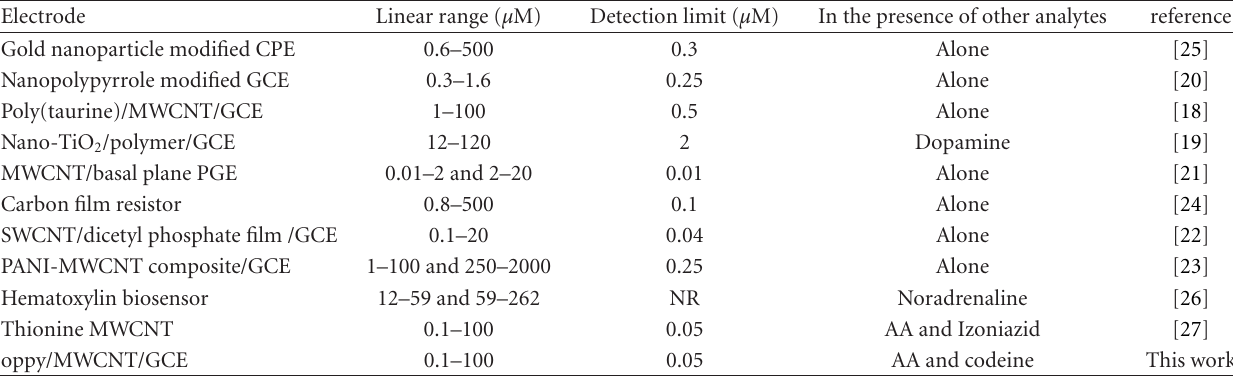
Table 1: Voltammetric response characteristics of the oppy/MWCNT/GCE toward AC in comparison to other reported